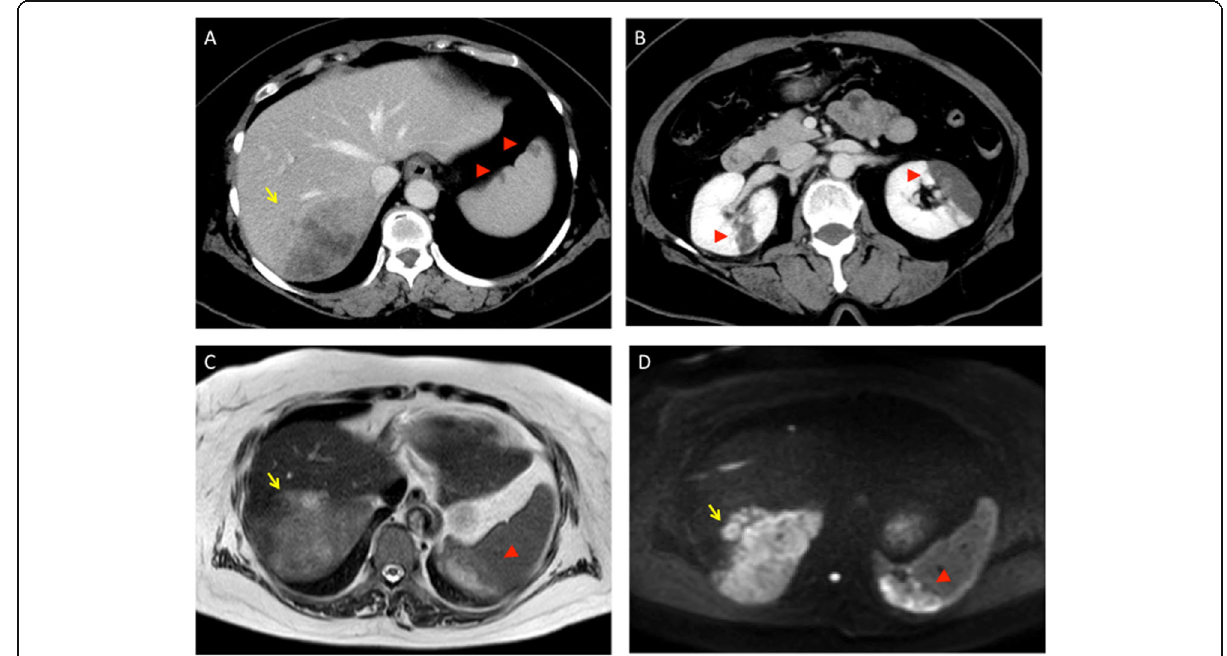
Fig. 1 Abdominal enhanced CT and MRI findings. a CT showing a tumor in the posterior segment of the right hepatic lobe (arrow) and splenic infarctions (arrowhead). b CT showing renal infarctions in both kidneys (arrowhead). c , d MRI showing a tumor in the posterior segment of the right hepatic lobe (arrow) and splenic infarctions (arrowhead). CT, computed tomography; MRI, magnetic resonance